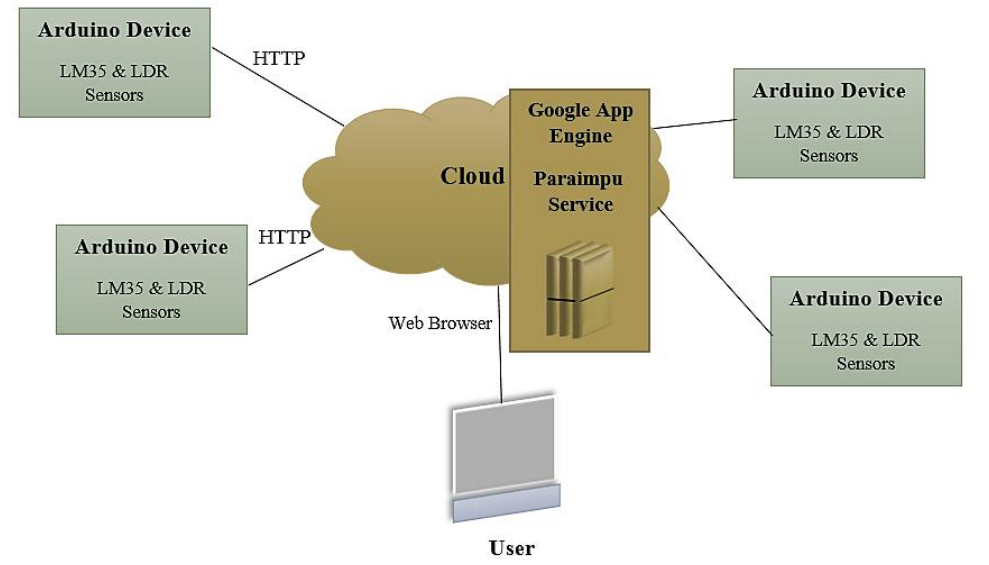
Figure 2. Smart home application based on